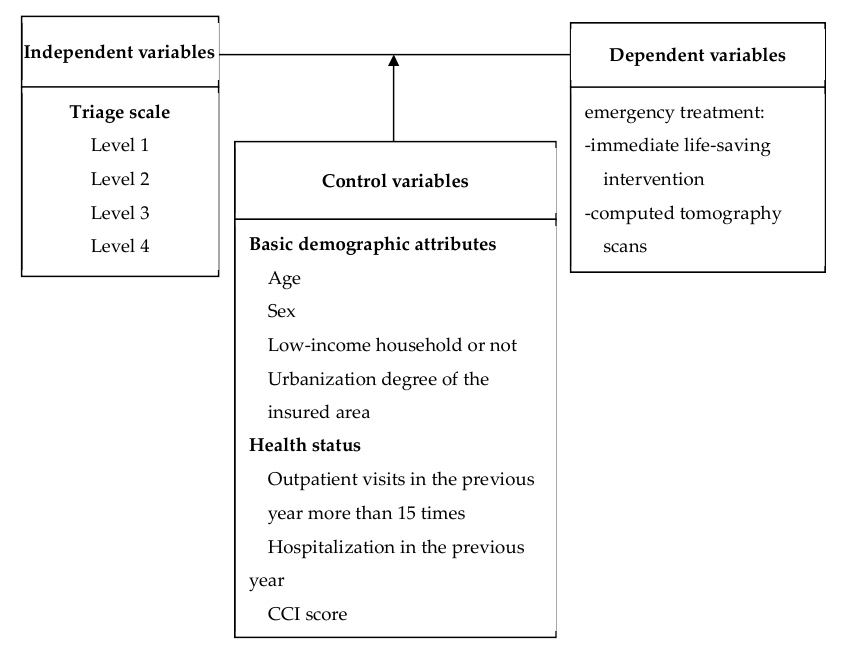
Figure 1. The statistical analysis was conducted using SPSS 16 software, and a P-value of < 0.05 was considered statistically significant.